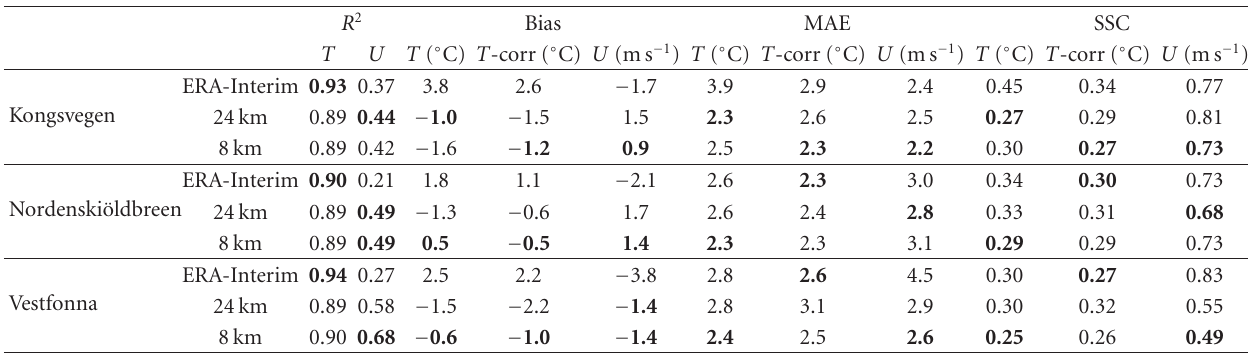
Table 2: Statistical evaluation of temperature and wind for the 2-year period (April 2008–March 2010). Kongsvegen record is from the whole period, Nordenski¨oldbreen record is from March in 2009 until March in 2010 (1 year), and Vestfonna record is from April in 2008 until April in 2009 (1 year). T -corr is height corrected temperatures. Bold numbers indicate the best result for each AWS. R 2